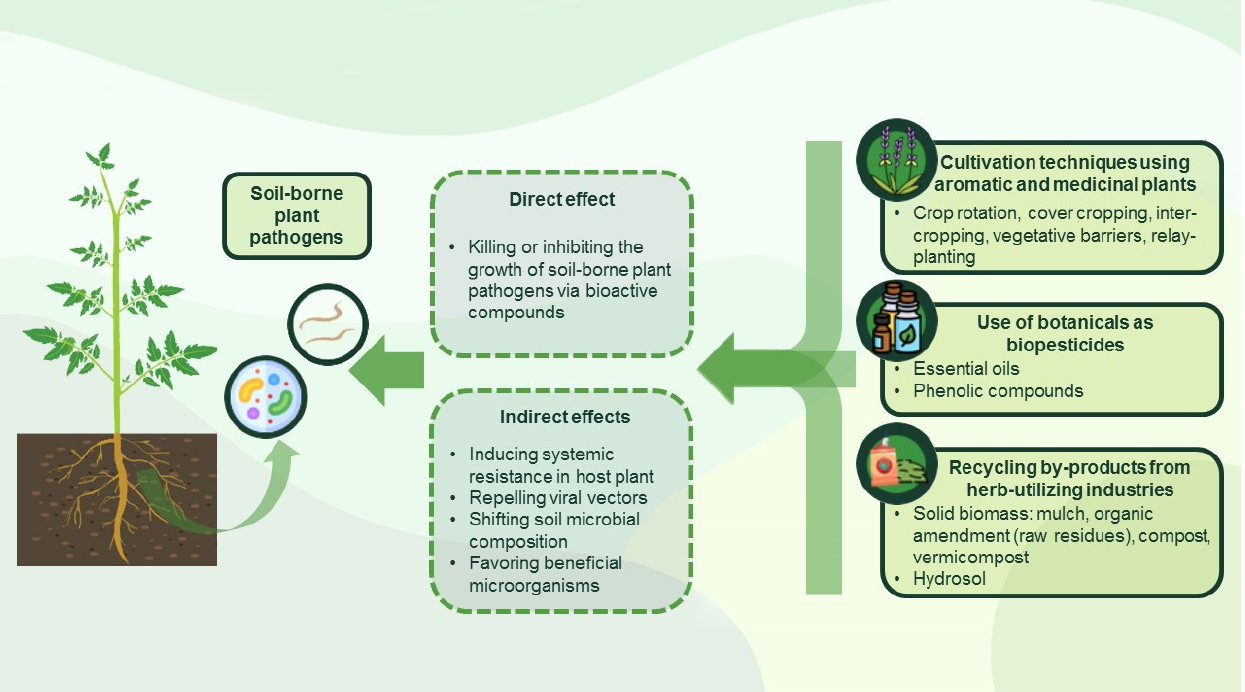
Figure 1. Aromatic and medicinal plants as part of non-chemical plant protections systems: effects and methods of application. The icons in circles were made by Blackwoods, Freepik, Kerismaker, and Surang (www.flaticon.com). The plant illustration on the left is based on the work of Mariya Kazakova (purchased from www.shutterstock.com).